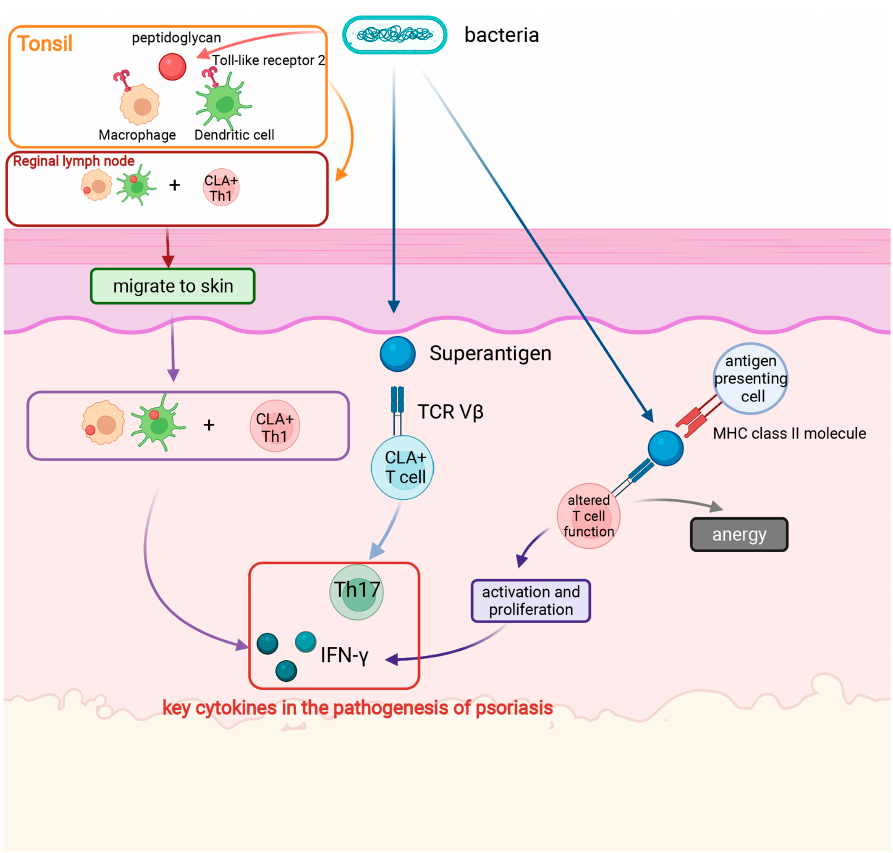
Figure 1. Roles of bacteria in psoriasis. Superantigens comprise a classical mechanism. Bacterial isolates generally express several superantigens. Superantigens bind to the outer surface of MHC class II proteins on the surface of antigen presenting cells, connecting them T cell receptors on the surface of T helper cells. T cells are then activated, leading to proliferation and production of cytokines (such as IFN- γ ). However, overstimulation promotes T cell failure and dysfunction, which is called anergy. In addition, superantigens increase T cell expression of the skin-homing receptor, cutaneous lymphocyte antigen, which further mediates Th17-dominated responses. Another mechanism is related to peptidoglycan (PG). Bacteria in the tonsil (and/or intestine) or PG released by bacteria can be absorbed by macrophages or dendritic cells, which then migrate to the skin where PG peptides are presented to antigen-specific Th1 cell clones. Released cytokines, especially IFN- γ , act on keratinocytes. Finally, excessive proliferation and incomplete differentiation of the epidermal layer occurs. Created with BioRender.com on 24 May